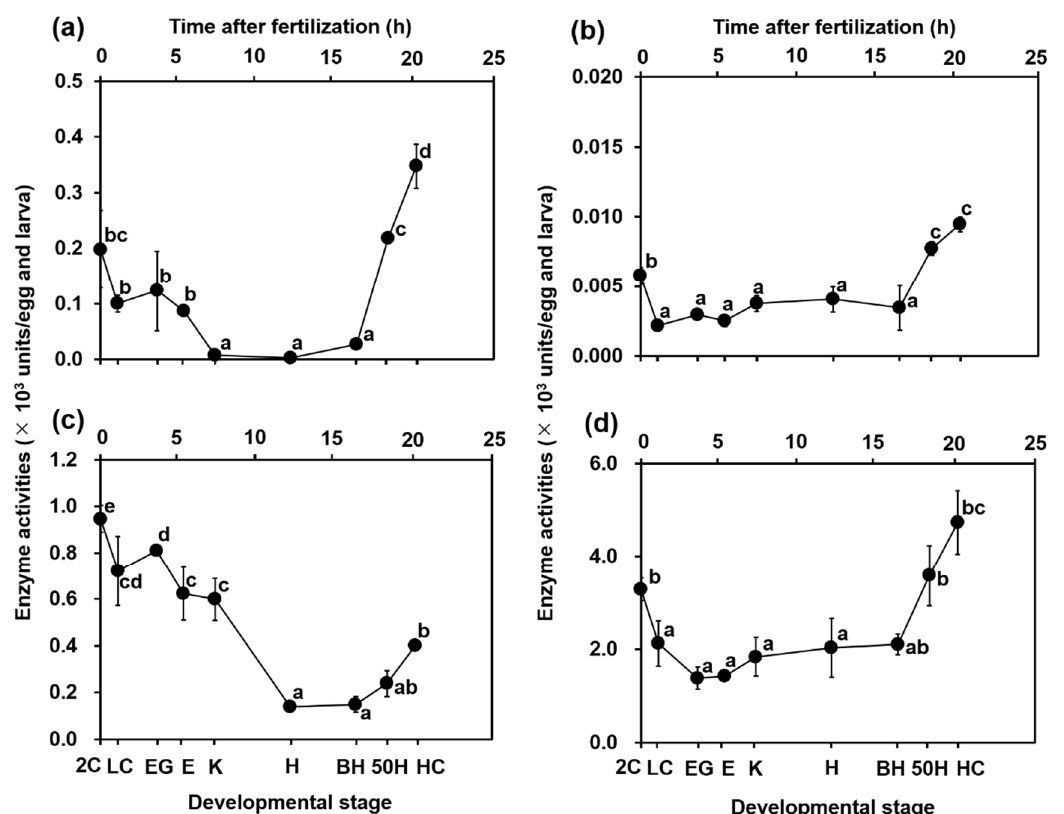
Figure 5. Changes in ( a ) aspartate aminotransferase (AST), ( b ) alanine aminotransferase (ALT), ( c ) alkaline phosphatase (ALP), and ( d ) creatine kinase (CK) activities with the development of yellowfin tuna eggs and yolk sac larvae. Values are presented as means ± SD. Letters next to values denote significant differences ( p < 0.05). Abbreviations are the same as those in Figure 2.